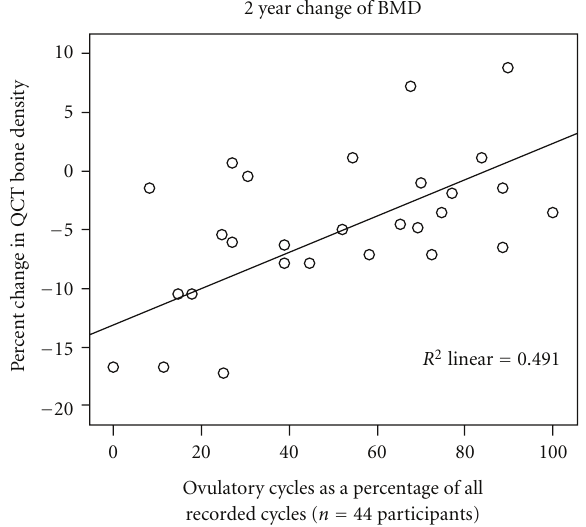
Ovulatory cycles as a percentage of all recorded cycles ( n = 44 Figure 5: The 2-year-change of trabecular lumbar spine bone min- eral density documented by Quantitative Computed Tomography (QCT) is shown by rate of ovulatory cycles in 28 women with complete ovulation data out of the 44 women studied prospectively in the ongoing PEKNO-Trial. Assessed by a commercially available ovulation monitor device, ovulation-likelihood was verified by luteal phase serum sampling. The graph illustrates the significant linear relationship ( r = 0 . 7; P < . 05) observed between the percent- age of ovulatory cycles and BMD loss in pre- and